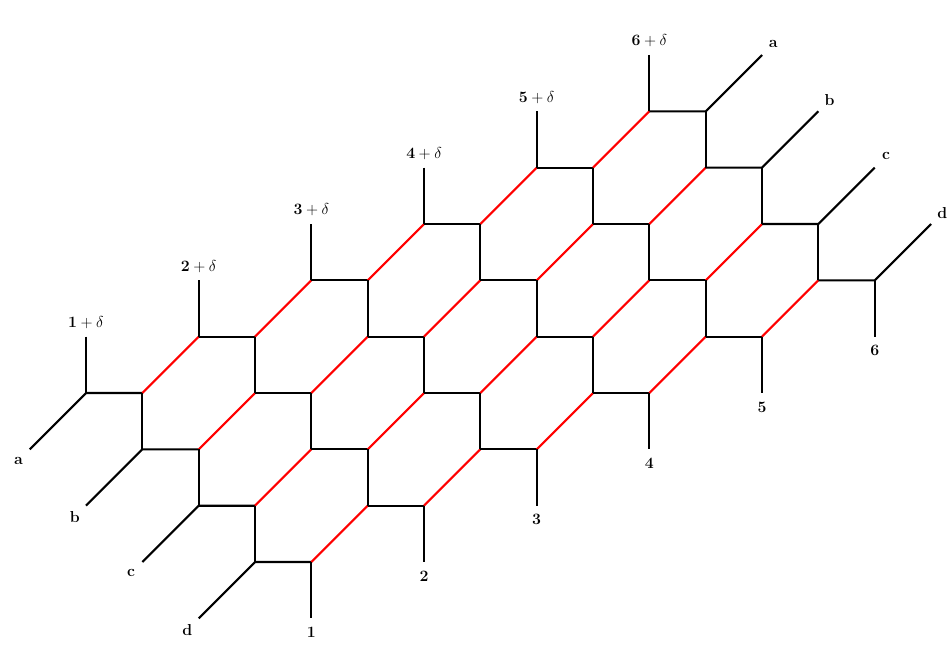
Figure 20 . (6 ; 4) web with shift (cid:14) after SL(2 ; Z ) transformation.